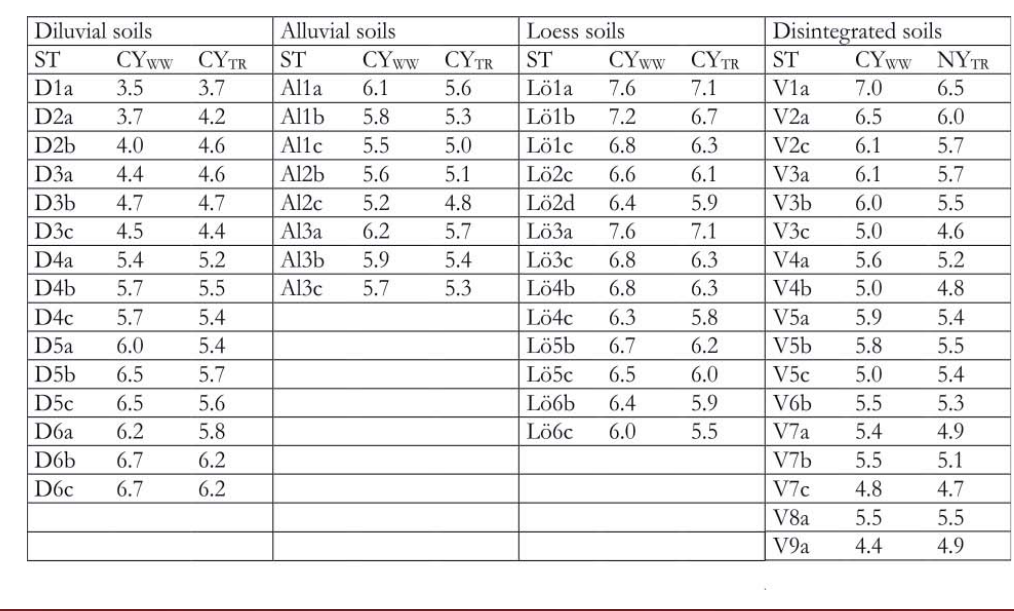
Table 1. Crop yield (CY, t ha -1 ) for winter wheat (WW) and triticale (TR), depending on